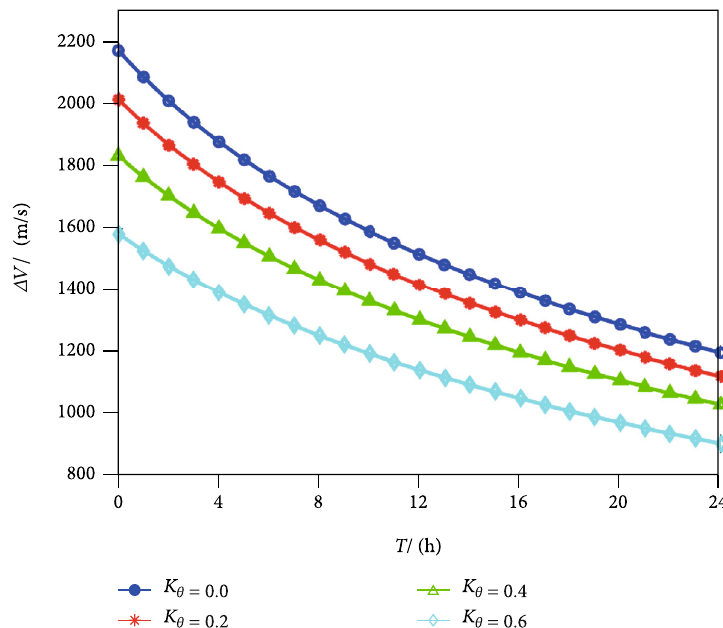
Figure 6: Abort impulse versus the abort time of the single-impulse abort orbit under di ff erent fl ight-path angle ratios.